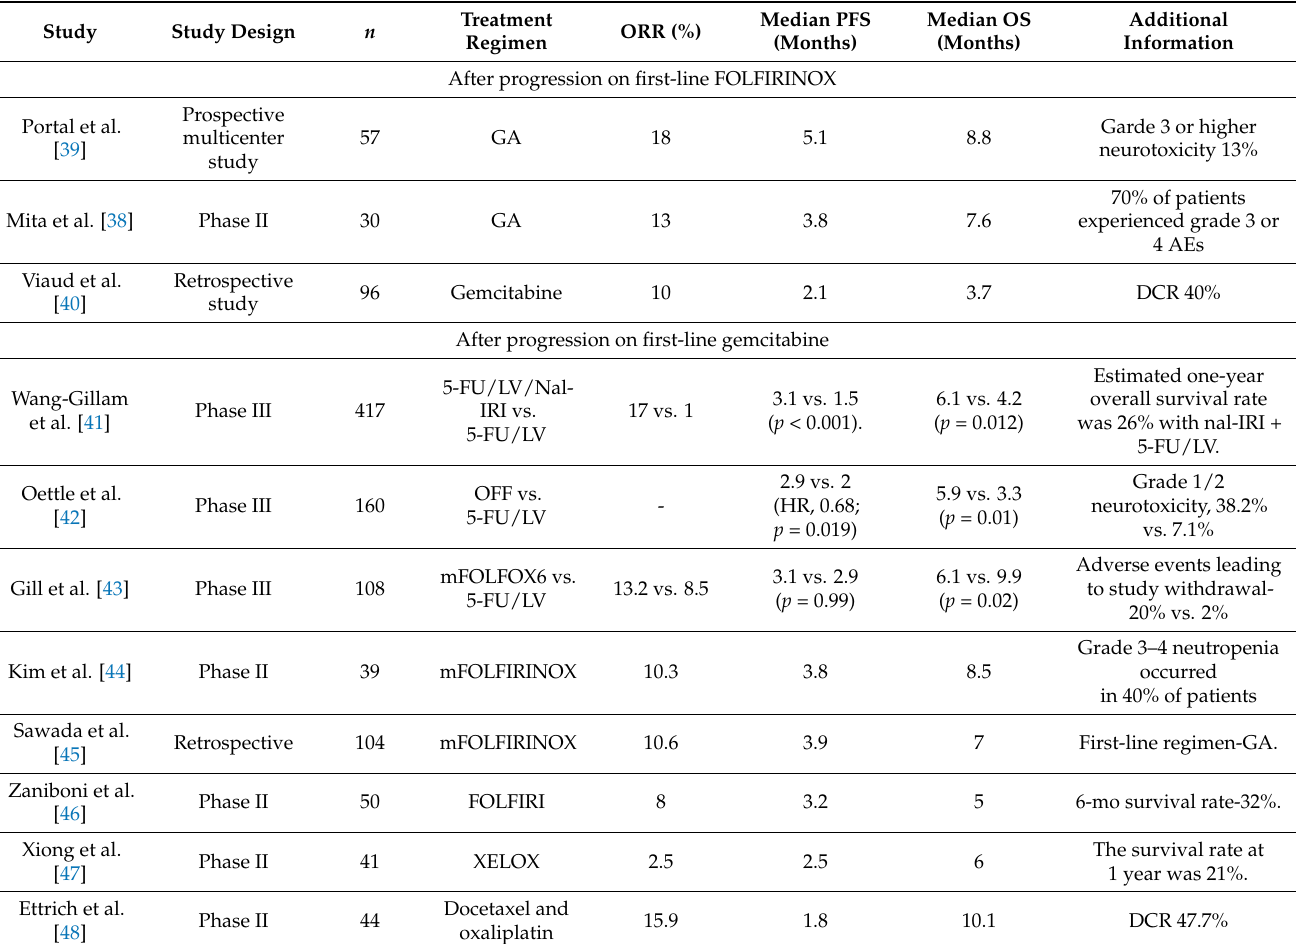
Table 3. Studies with second-line chemotherapy in patients with metastatic pancreatic ductal